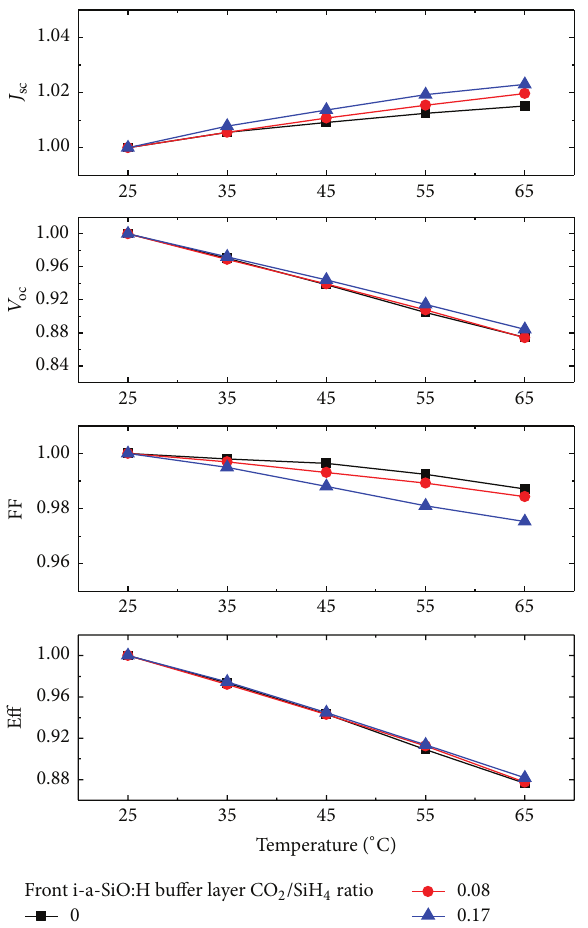
Figure 7: Normalized solar cell parameters measured in the initial state for the c-Si-HJ solar cells with a CO 2 /SiH 4 ratio in the front i-a-SiO:H buffer layers as a function of the operating